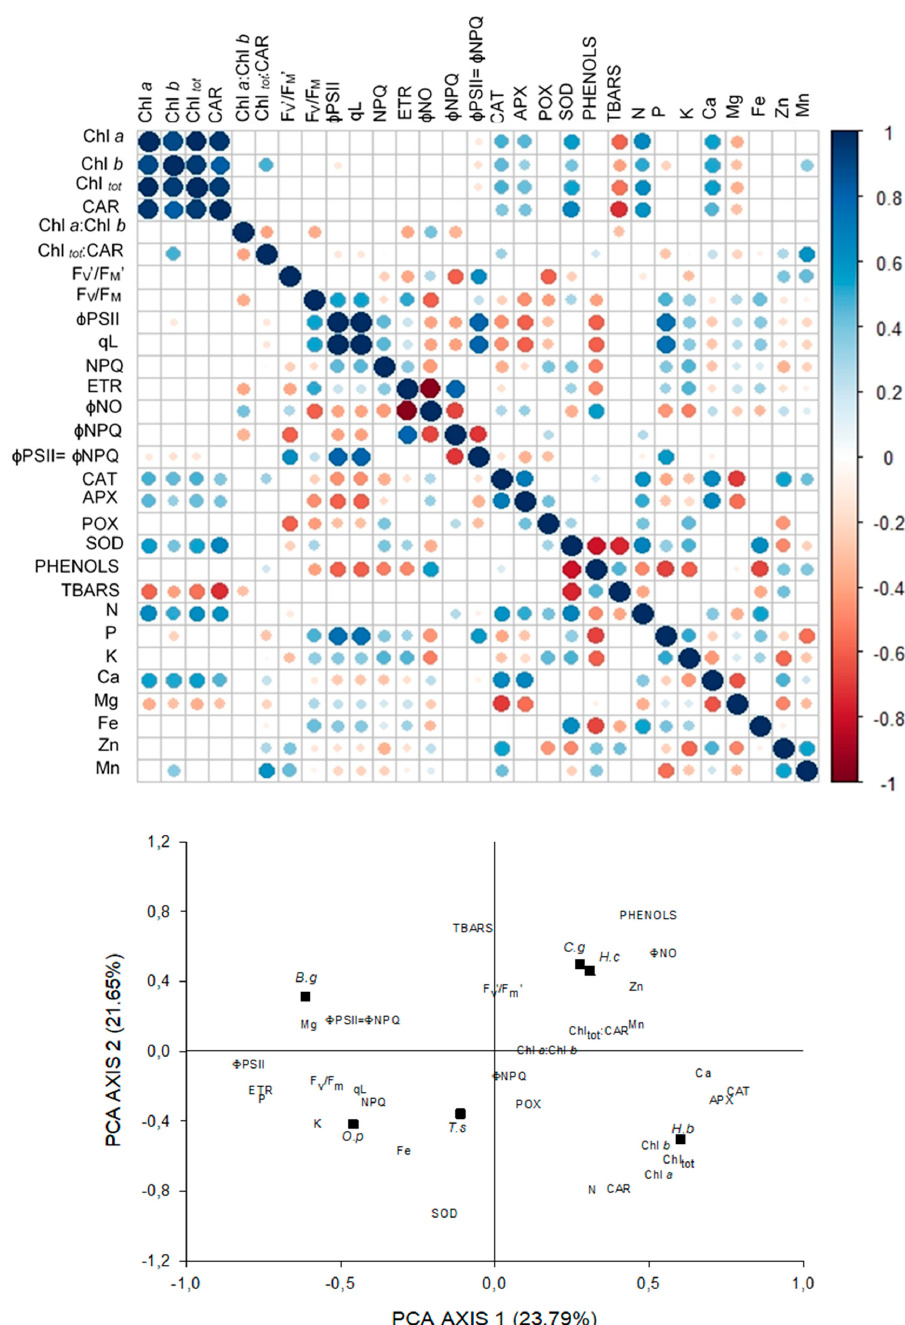
Figure 2. Correlations between pigments content, fluorescence parameters, antioxidant enzymatic activity, phenolic compounds, lipid peroxidation, and foliar concentration of nutrients in six tree species under full sunlight, and principal components analysis of the 29 variables studied. Black squares represent the species: Hymenea courbaril (H.c); Carapa guianensis (C.g); Hevea brasiliensis (H.b); Tabebuia serratifolia (T.s); Bellucia grossularioides (B.g), and Ochroma pyramidale (O.p).